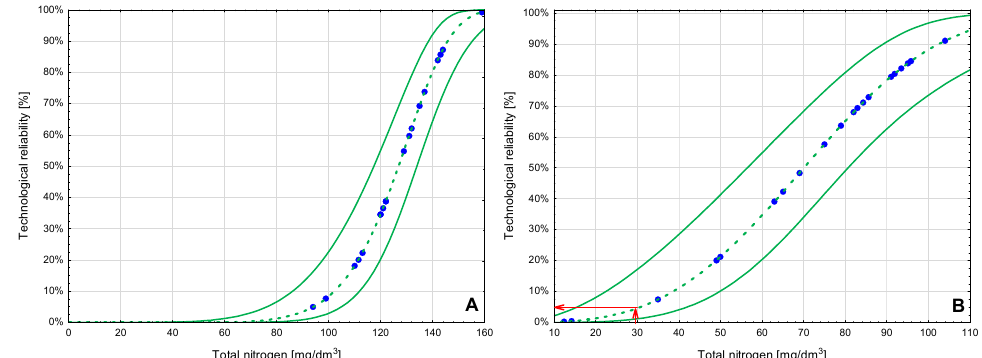
Figure 6. Weibull cumulative distribution functions and the technological reliabilities determined for TN (( A )—facility no. 1; ( B )—facility no. 2). Notation : dashed green line—reliability function, continuous green line—confidence intervals, red arrows—probability of achieving the indicators limit in the effluent.